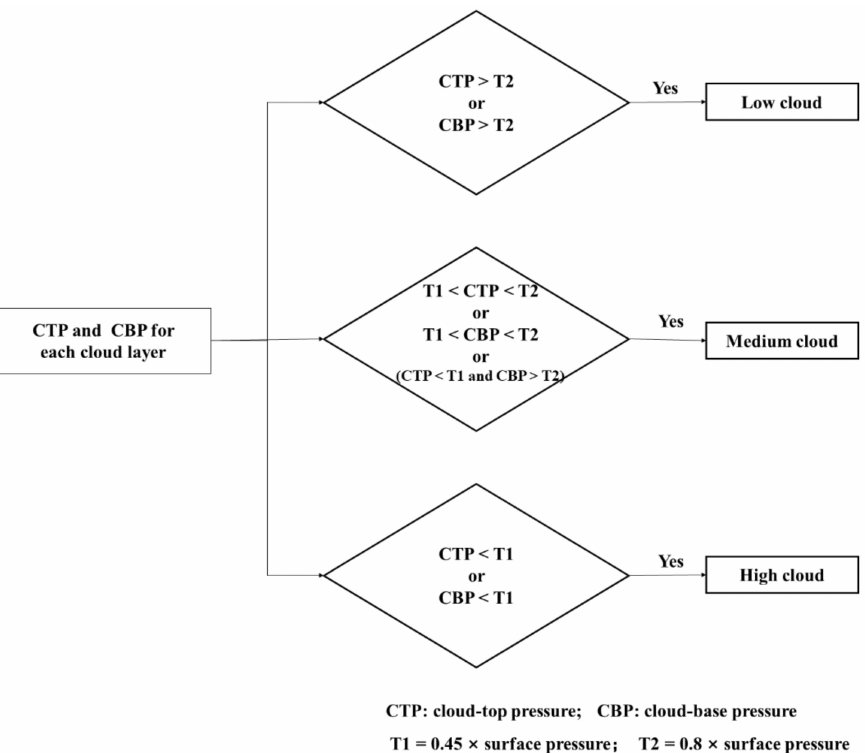
Figure 4. Decision flowchart for high, medium, and low cloud classification based on CTP and